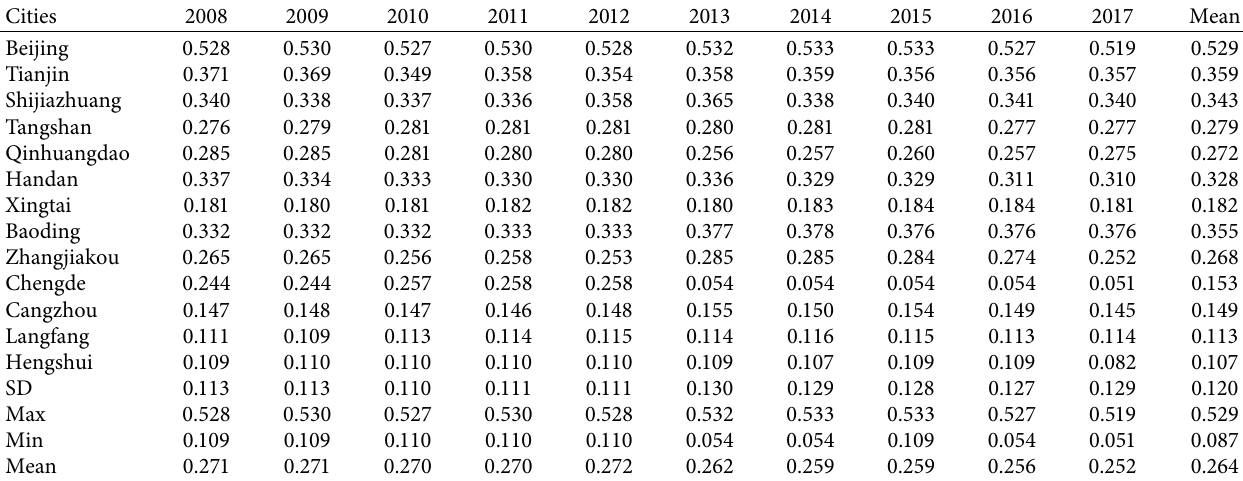
Table 4: Results of Gini coefficient of urban scale of Beijing-Tianjin-Hebei Metropolitan (2008–2017).